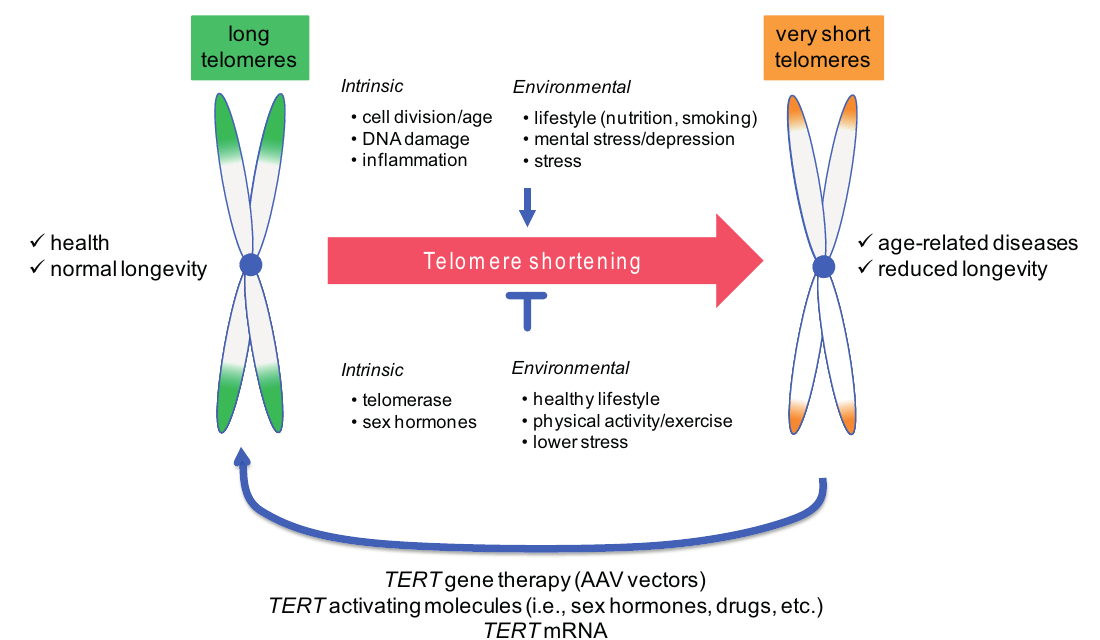
Figure 1. Telomeres in aging and disease. Telomere shortening is a life-long process that is influenced by a number of intrinsic and environmental factors that either accelerate or slow down natural telomere attrition, which causes aging and the emergence of age-related diseases. The identification of telomere shortening as a driver of molecular aging has triggered the development of telomerase-based strategies to (re)elongate telomeres and thus to delay aging and associated disease. Abbreviations: AAV, adeno-associated vectors; TERT, telomerase reverse